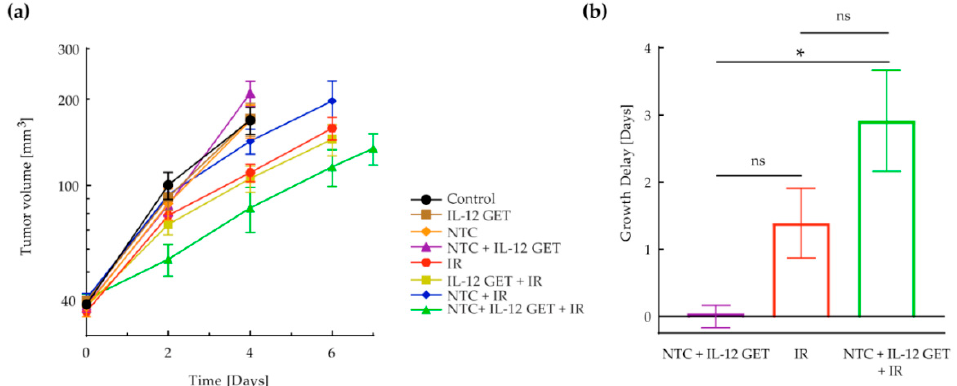
Figure 2. Pilot B16 ‐ F10 vaccination. ( a ) Tumor growth curve. Tumor volume in a logarithmic scale was plotted against time. ( b ) Tumor growth delay based on tumor doubling time. Eight treatment groups with six mice were included in the experiment. The control group received a mock vaccine. The